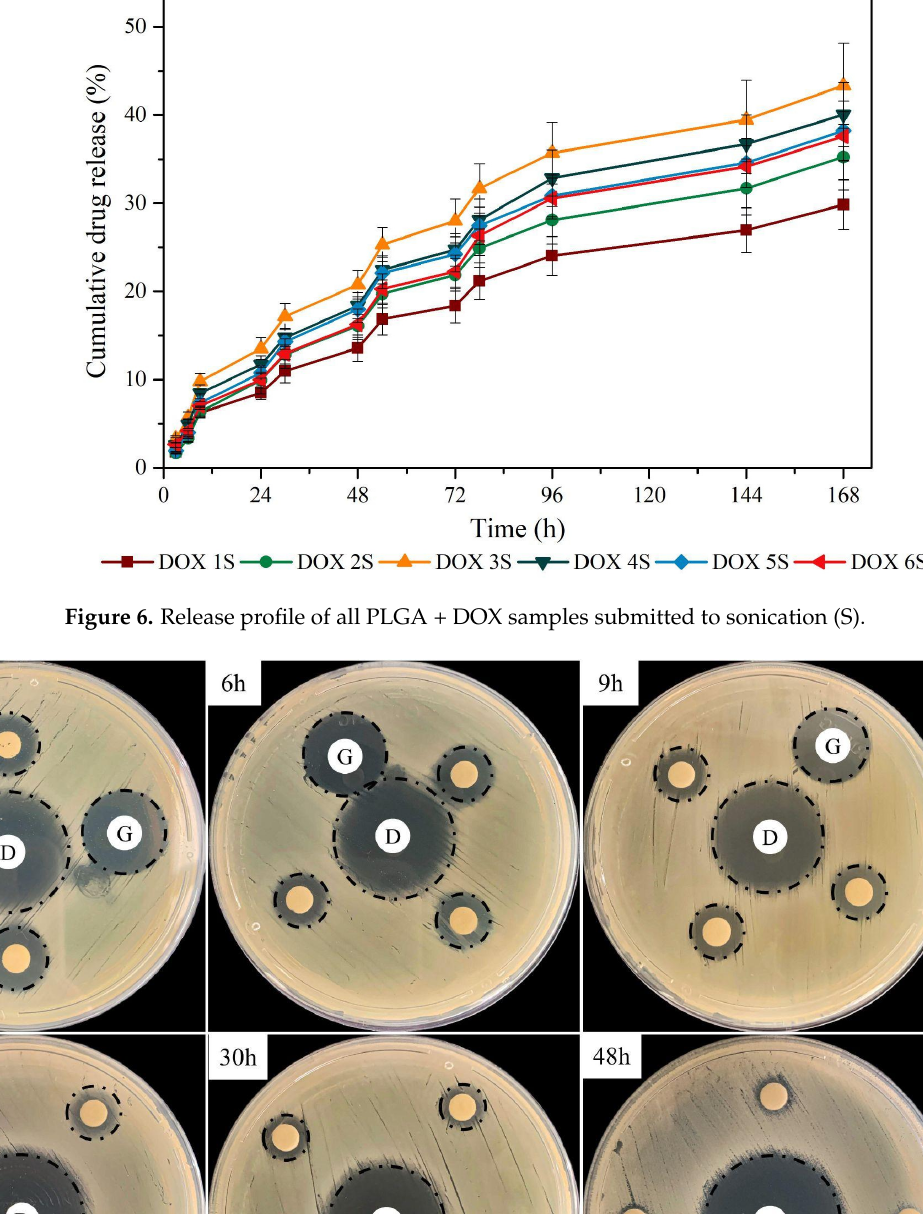
Figure 5. Release profile of all PLGA + DOX samples submitted to magnetic rotation (MR).